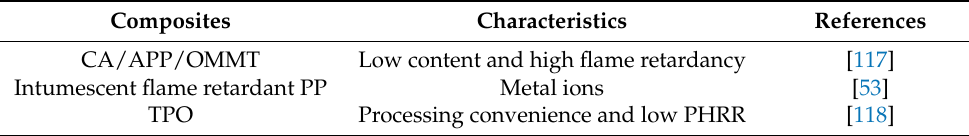
Table 4. Expandable flame retardants and their characteristics.